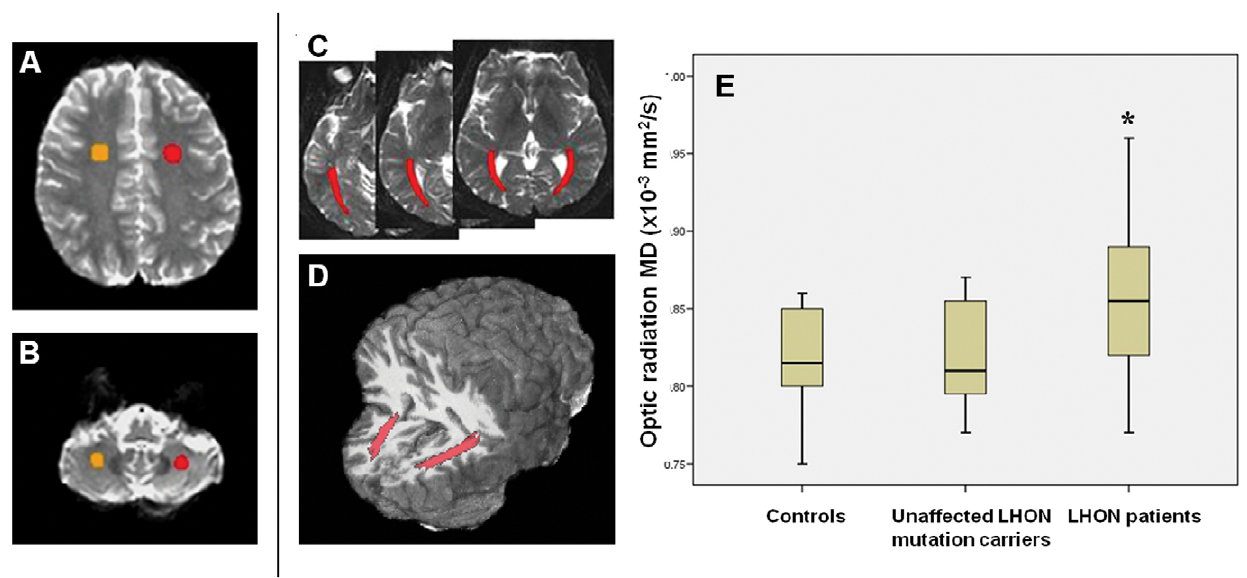
Figure 1. Segmentation of ROIs including prefrontal white matter (A), cerebellar white matter (B) and optic radiation (C) on axial T2 images. D: 3D reconstruction of optic radiation ROIs on a registered T1 volumetric image. E: Box-plot of MD values of optic radiations in controls, LHON healthy carriers and LHON patients. (Each box shows the median, quartiles, extreme values; *=P , 0.01).